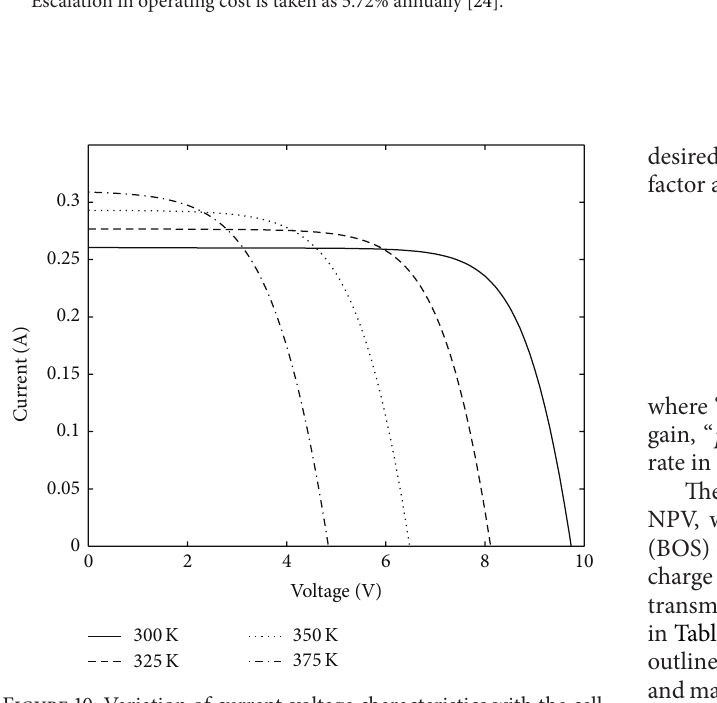
) to find initial investment cost (numbers provided here are in accordance P